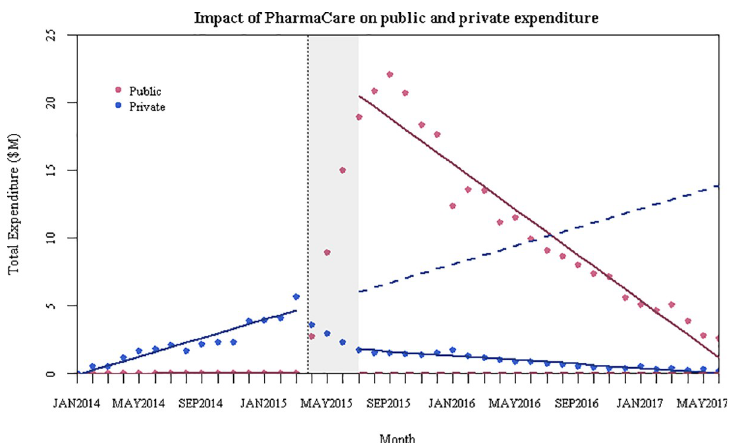
Fig 3. Interrupted time series model for the impact of PharmaCare on public and private expenditure on sofosbuvir and ledipasvir-sofosbuvir.